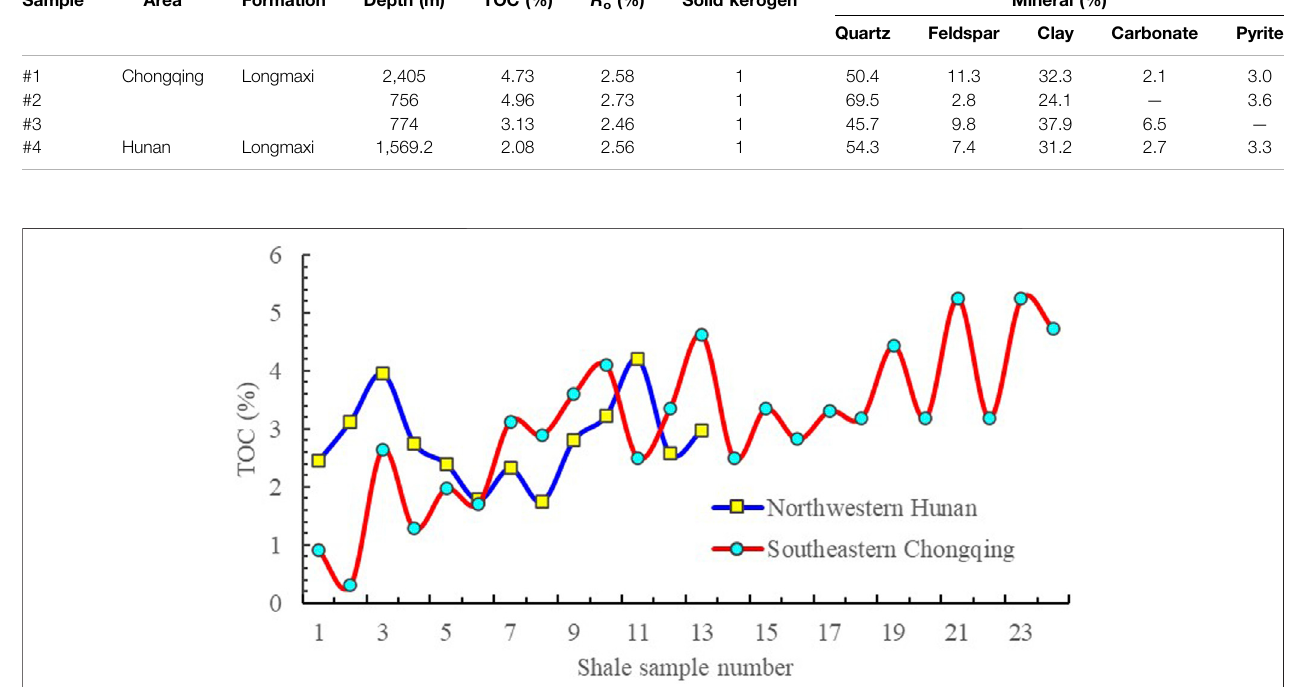
FIGURE 4 | TOC content distribution of the Longmaxi shale samples in Chongqing and Hunan.